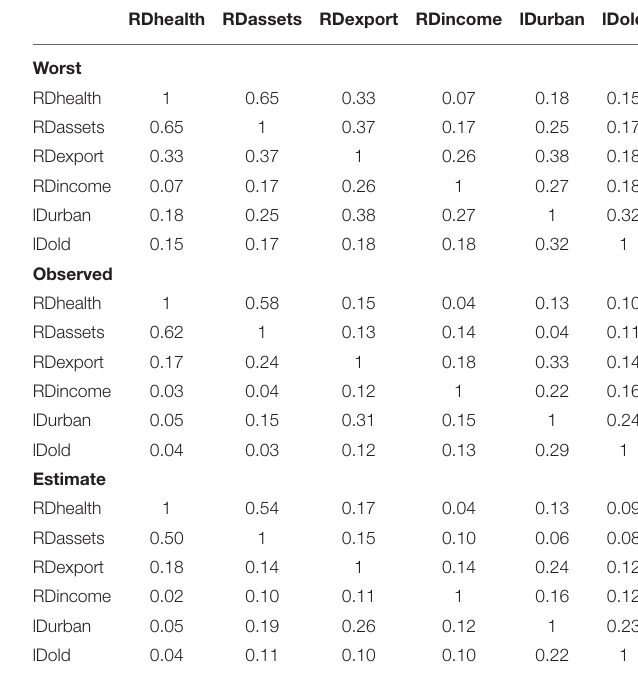
TABLE 3 | Correlation coefficient